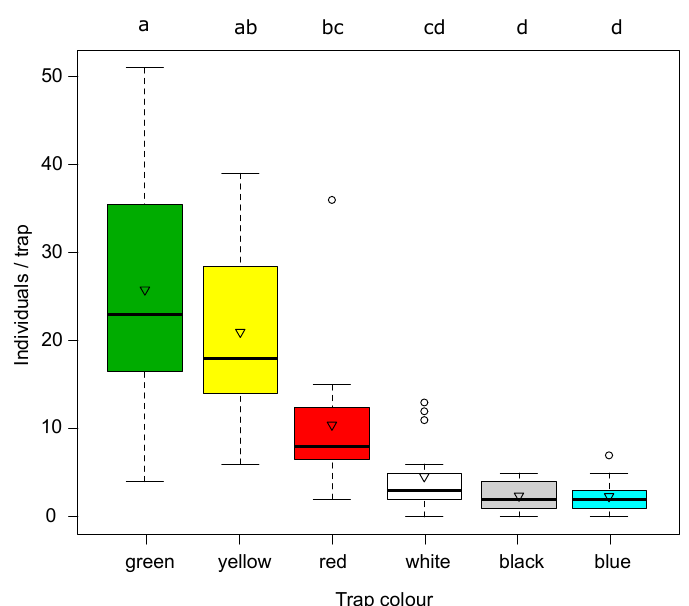
Figure 5. Catches of SBW adults on sticky traps of different colors. The boxes enclose the first and third quartiles; the ends of the whiskers represent the 5th/95th percentiles, the solid lines the median and the triangle the mean. Different letters indicate statistically significant differences between treatments (Tukey’s test following ANOVA, p < 0.05).